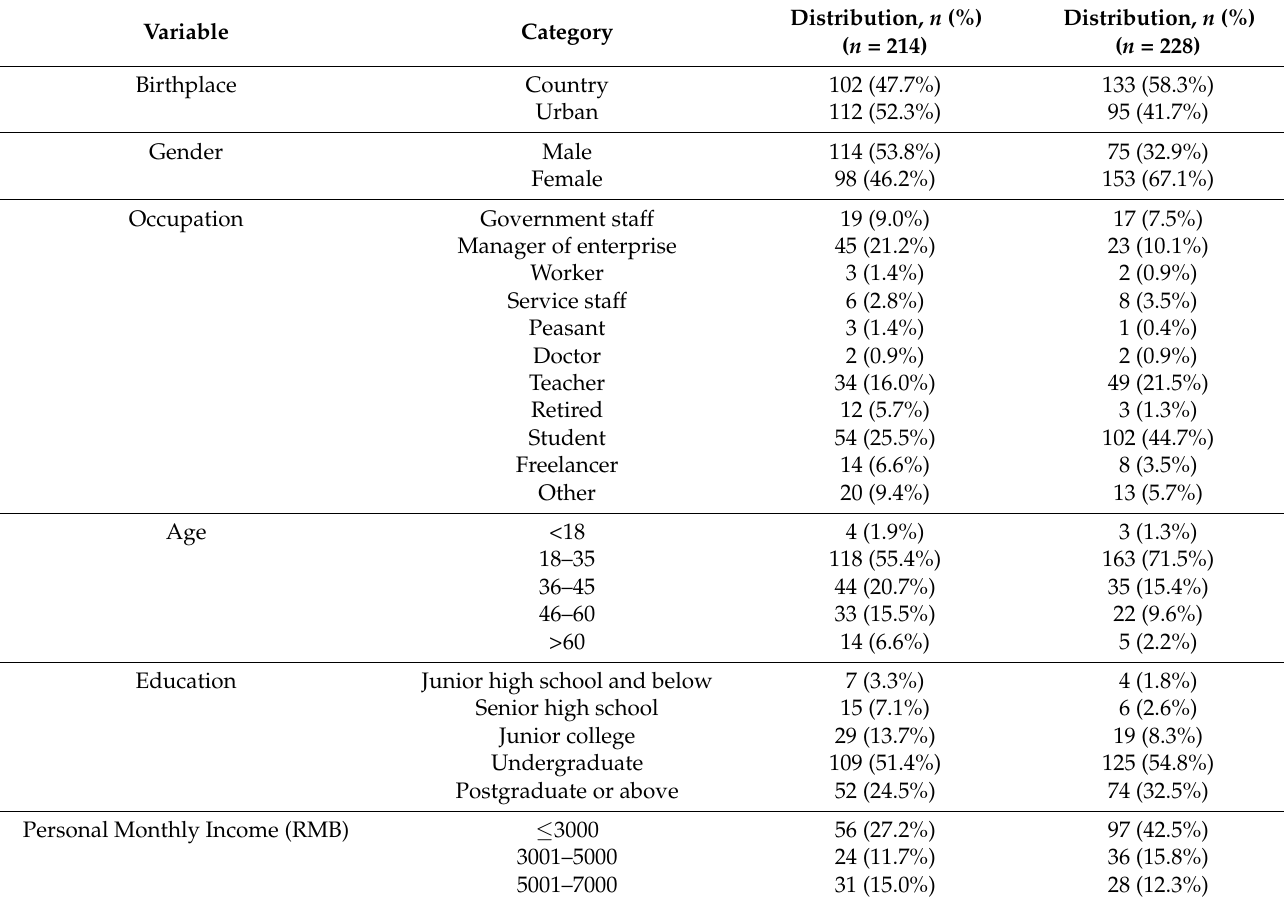
Table 3. Demographic profiles and trip characteristics of